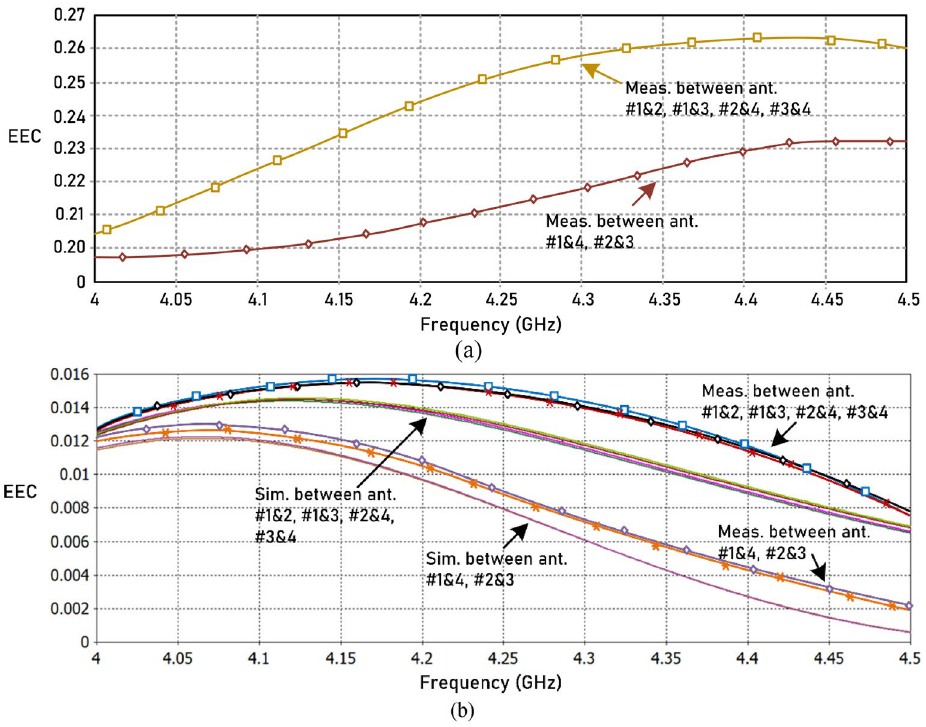
Figure 15. ( a ) Measured ECC between the four antennas for the 4-element reference array, and ( b ) simulated and measured ECC between the four antennas in the proposed 4-element antenna